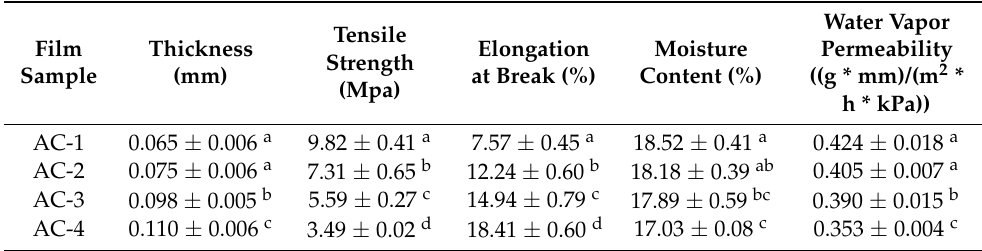
Table 1. The thickness, tensile strength, elongation at break, moisture content and water vapor permeability of SA–AG hydrogel-based